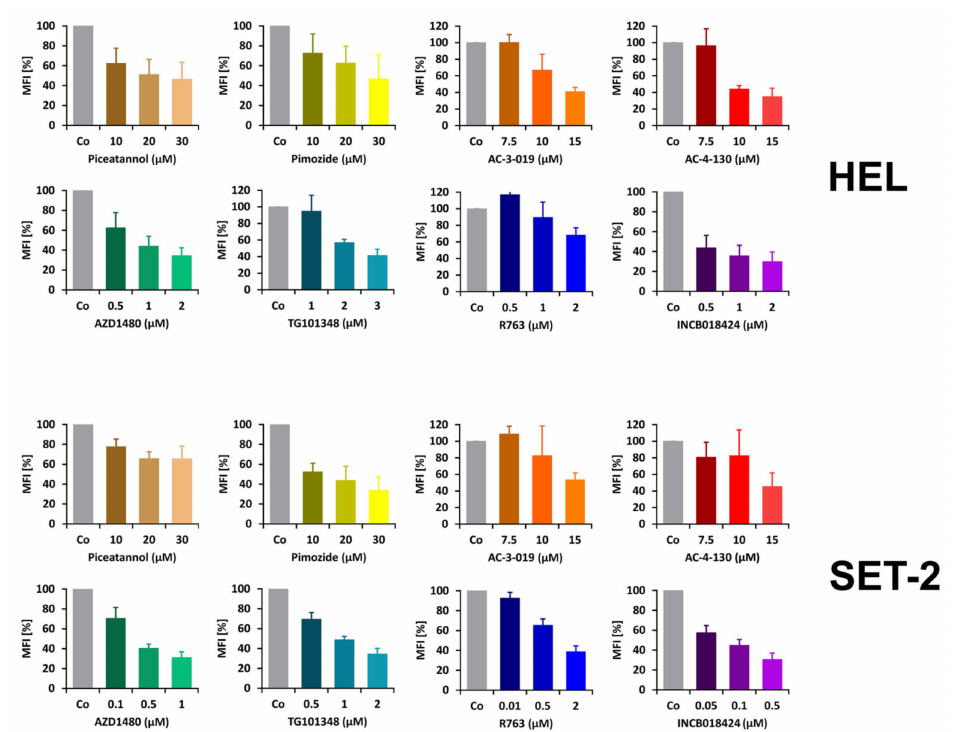
Figure A2. HEL and SET-2 cells were incubated with various concentrations of JAK2-targeting drugs (ruxolitinib, R763, TG101348, AZD1480) or STAT5-targeting drugs (piceatannol, pimozide, AC-3-019, AC-4-130) for 4 h. Thereafter, expression of pSTAT5 was analyzed by multicolor flow cytometry. The levels of pSTAT5 are depicted as median fluorescence index (MFI) values relative to the untreated control (Co).